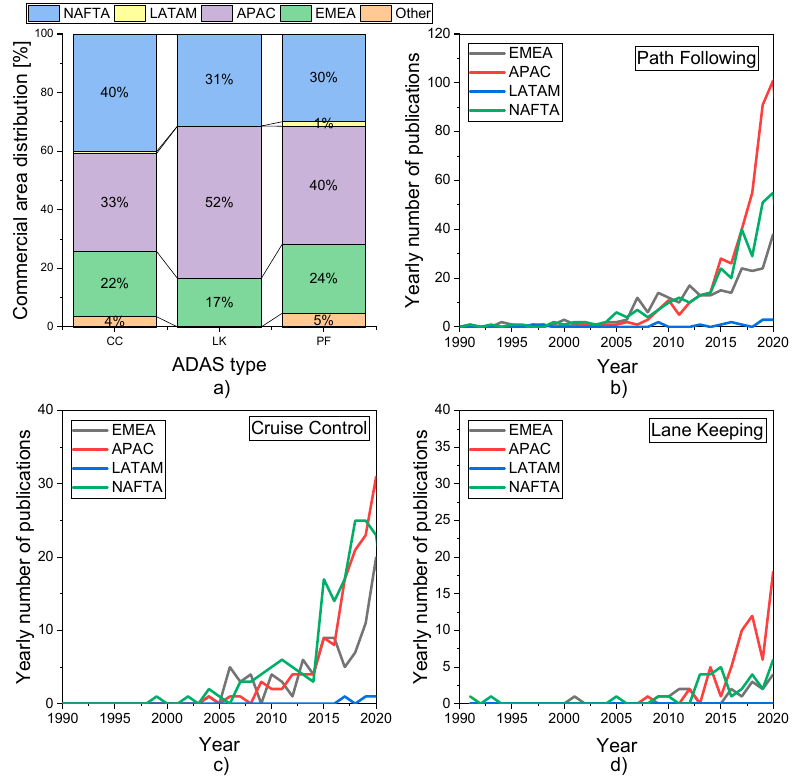
Figure 2. Geographical data analysis of the papers on MPC use in ADAS found in the Scopus database: ( a ) percentage distribution; ( b ) Path Following; ( c ) Cruise Control; and ( d ) Lane Keeping.